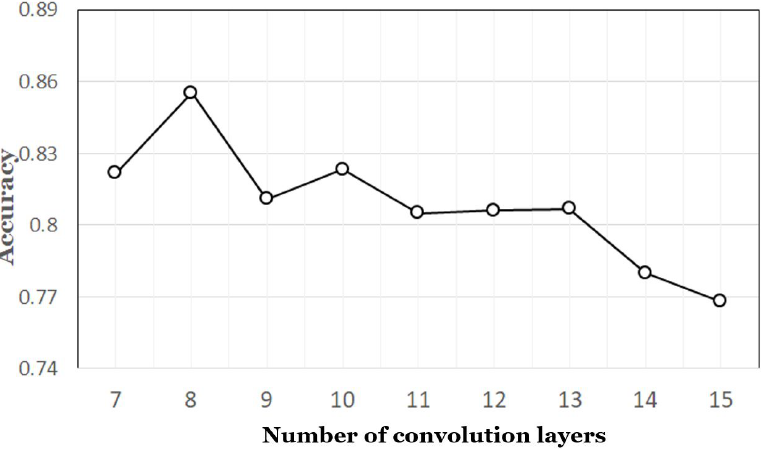
Figure 10. Changes in classification accuracy on variation of the number of convolutional layers in the concept-wise